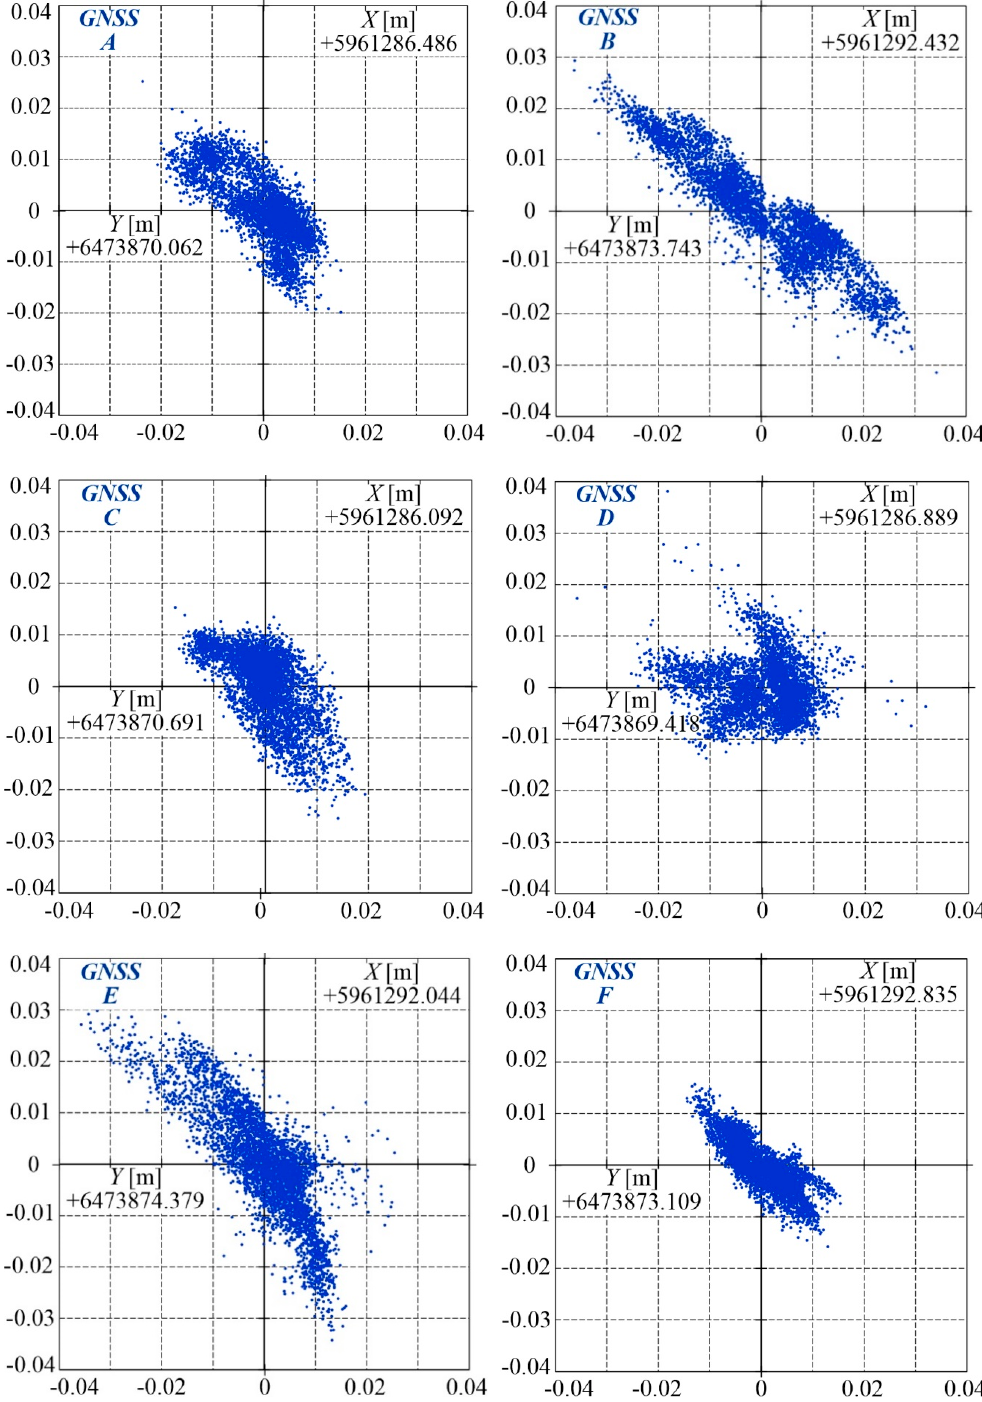
Figure 5. Results of position measurements for receivers A , B , …, F on static condition.